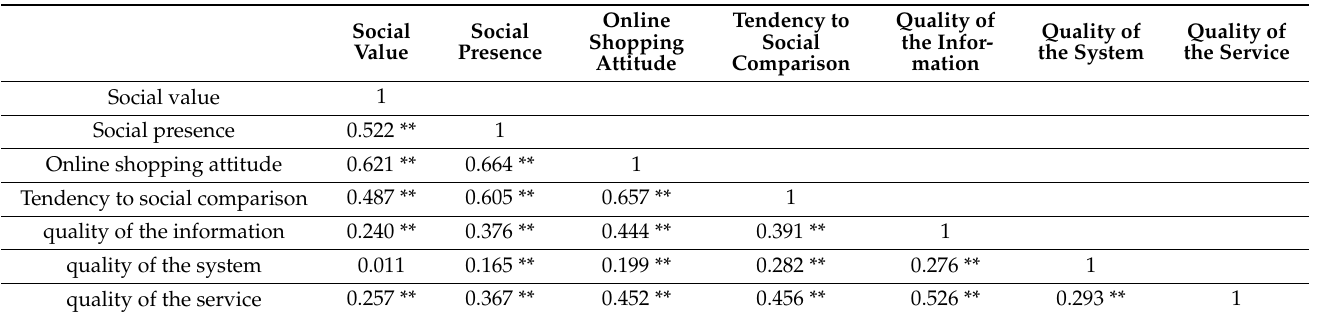
Table 8. Relationship between model’s variables (Pearson correlation